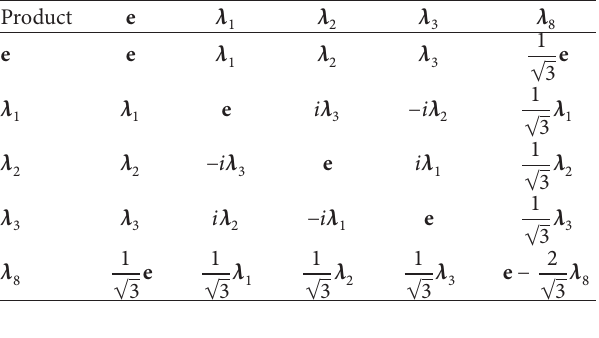
Table 3: Multiplication table of Gell-Mann matrices { 𝜆 4 , 𝜆 5 , 𝜆 − 3 , 𝜆 − 8 } (left times top).